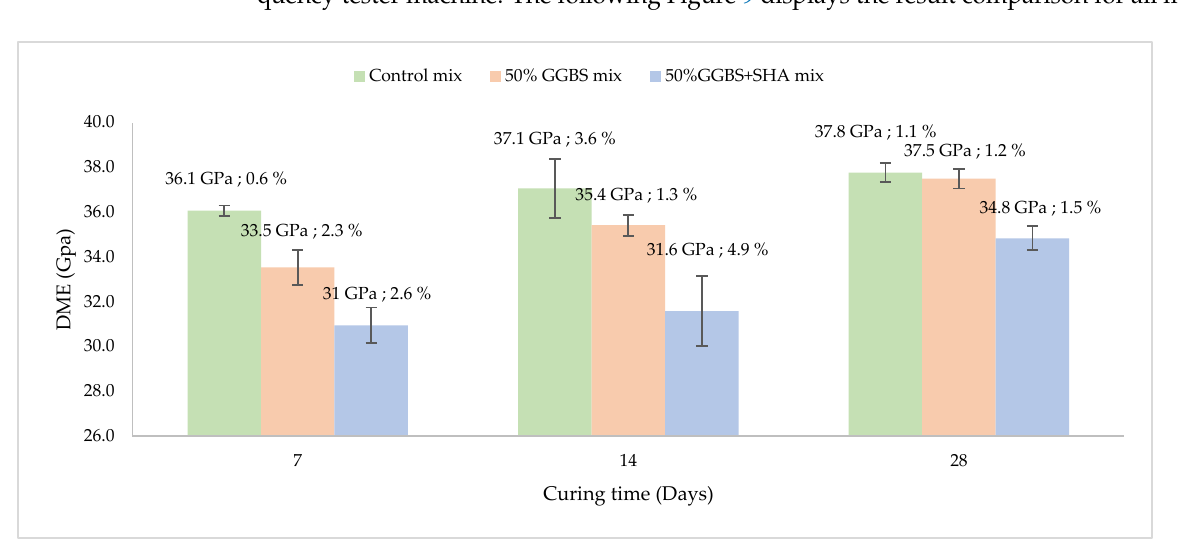
Figure 9. Mix comparison (Dynamic modulus of Elasticity; Coefficient of variation). From the control mix in the figure above, the evolution of the dynamic modulus of elasticity for the control mix is observed throughout the 28 days of curing, with an increase of 5% from the seventh to the 28th day.